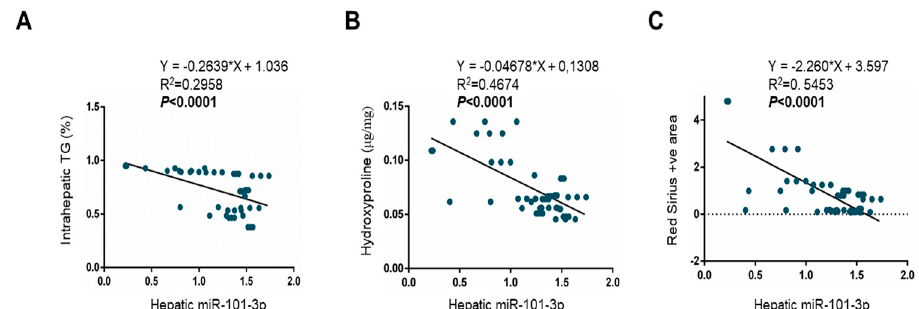
Figure 3. Hepatic miR-101-3p downregulation was related to all spectra of liver damage. Correlation analyses between miR-101-3p expression and intrahepatic triglyceride (TG) content (%) ( A ), hydroxyproline ( µ g / mg) concentration, representative of collagen deposition ( B ), and Red Sirius positive area, quantified by ImageJ software in 10 random non-overlapping fields for each mouse ( C ). miR-101-3p expression was evaluated by qRT-PCR in lysates from total livers from wt (InsR+/+) and InsR +/ − mice fed either an SD or MCD diet ( n = 10 mice / group). Data were normalized for hsa-miR-361-5p, hsa-miR-186-5p, hsa-miR-26a-5p, hsa-miR-191-5p, hsa-miR-451-5p, and hsa-miR-423-5p average expression.